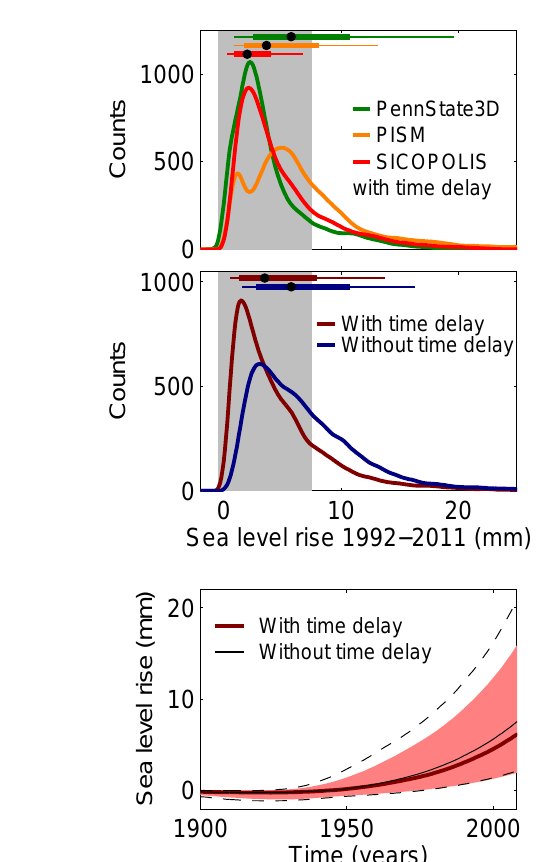
Figure 7. Uncertainty range including climate, ocean and ice-sheet uncertainty for the projected change of the observational period 1992–2011. Upper panel: probability distribution for the three mod- els with explicit representation of ice shelves (PennState-3D, PISM, SICOPOLIS). Middle panel: probability distribution with time de- lay (dark red) and without (dark blue) for three the models with explicit ice-shelf representation (shelf models). The grey shading in the upper two panels provides the estimated range from observa- tions following Shepherd et al. (2012). The likely range obtained with time delay is almost identical to the observed range. All dis- tributions are highly skewed towards high sea-level contributions which strongly influences the median (black dot at the top of the panel), the 66% range (thick horizontal line) and the 90% range (thin horizontal line). Lower panel: time evolution for the hindcast projection using only the shelf models: with time delay, one obtains the red line as the median time series; the red shading provides the likely or 66% range. The black line shows the median without time delay together with the likely range for this case as dashed lines.